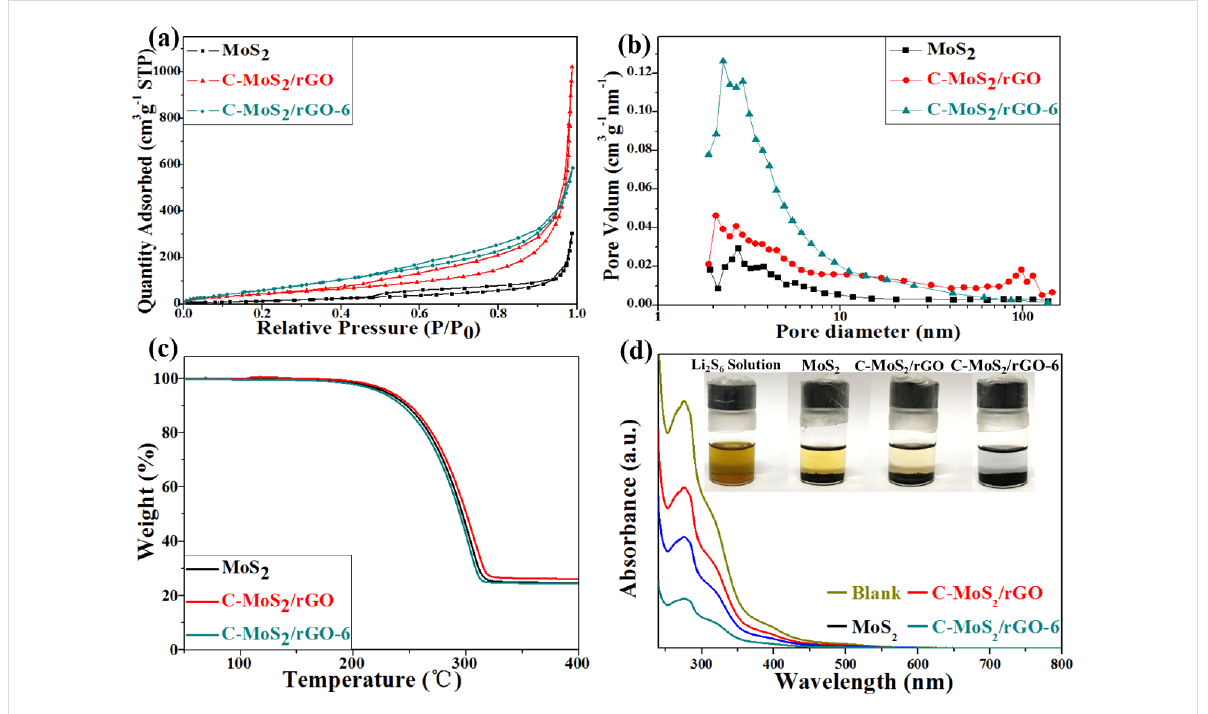
Figure 5: (a) N 2 adsorption–desorption isotherms and (b) corresponding pore size distributions of pristine MoS 2 , and C-MoS 2 /rGO and C-MoS 2 /rGO- 6 composites. (c) TG curves of MoS 2 -S, C-MoS 2 /rGO-S and C-MoS 2 /rGO-6-S composites; (d) UV–vis absorption spectra of the pure Li 2 S 6 solution and Li 2 S 6 solutions with pristine MoS 2 , and C-MoS 2 /rGO and C-MoS 2 /rGO-6 composites (inset: photos of the Li 2 S 6 solution after 12 h of adsorption experiments with the same amount of pristine MoS 2 , or C-MoS 2 /rGO and C-MoS 2 /rGO-6 composites).